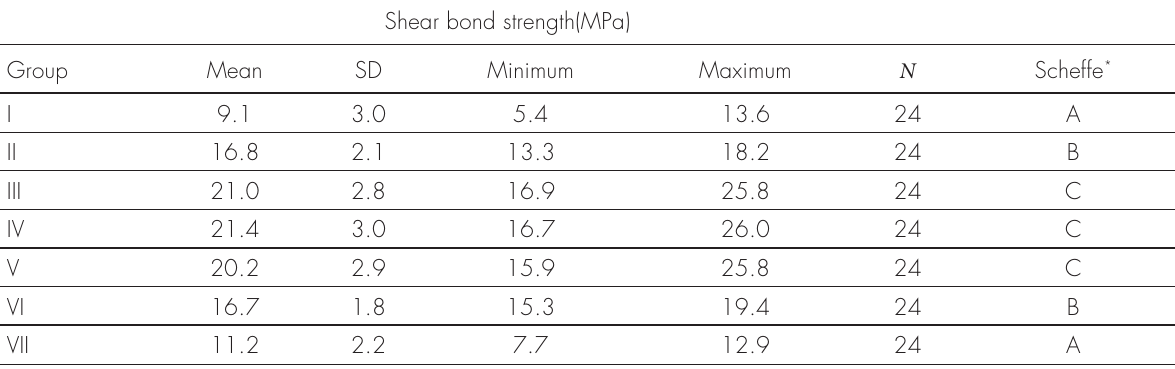
SD, standard deviation; *Groups with different letters are significantly different from each other.